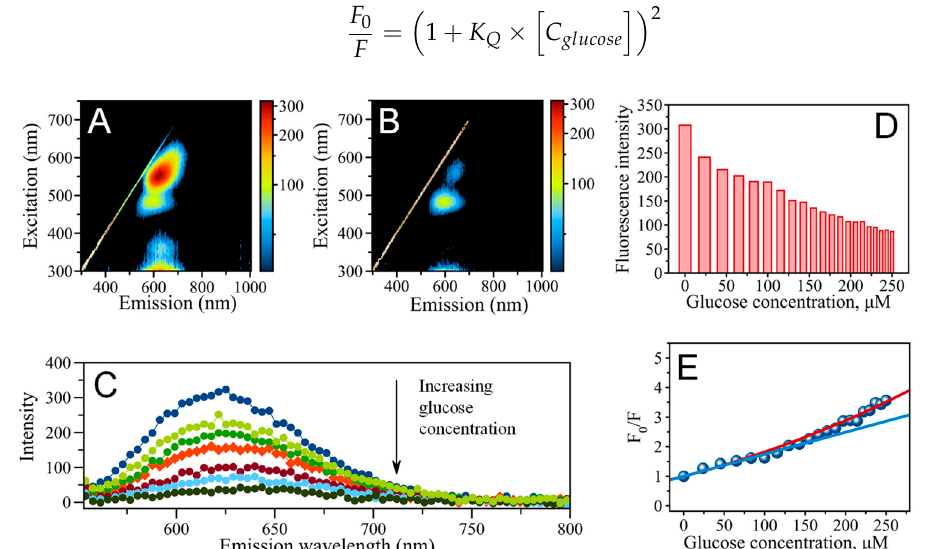
Figure 2. ( A ) EEMS showing emission pattern of AgNC@hpC 12 mixed with GOx but without added glucose, ( B ) emission–excitation map showing emission pattern of AgNC@hpC 12 mixed with GOx with ~230 µ M glucose added, ( C ) fluorescence spectra of AgNC@hpC 12 ( λ EXC = 550 nm) with successive additions of glucose, the spectra show a drop in intensity of fluorescence upon increase of C glucose in the range between 0–250 µ M, ( D ) fluorescence intensities of AgNC@hpC 12 in response to glucose addition, and ( E ) Stern–Volmer, F 0 /F vs. C glucose , plot; solid blue line is a linear fit in the C glucose range of 0–150 μ M; solid red line is a fit with Equation (2).